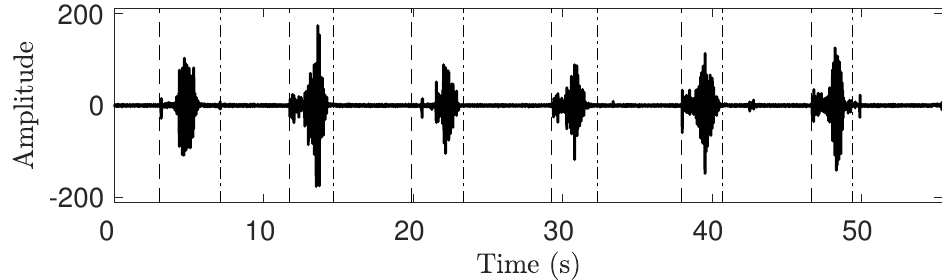
Figure 3. Example of recorded electromyography (EMG) signal. Dashed lines show start and end points of